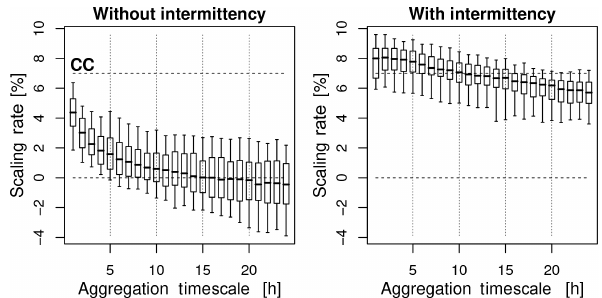
Figure 8. Box plots of estimated scaling rates of 95th rainfall quan- tile with temperature as a function of timescale. Each box plot shows the 0, 25, 50, 75 and 90% quantiles of all 99 stations in the